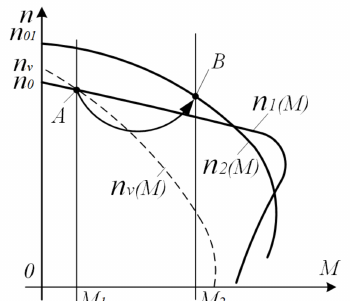
Figure 7. Mechanical characteristics of an asynchronous drive with vector control and a PID speed controller. n 1 ( M ) is the initial mechanical characteristic at low load, n ν ( M ) is the mechanical charac- teristic with increasing f , n 2 ( M ) is the mechanical characteristic of the drive with zero speed error and increased frequency of the stator